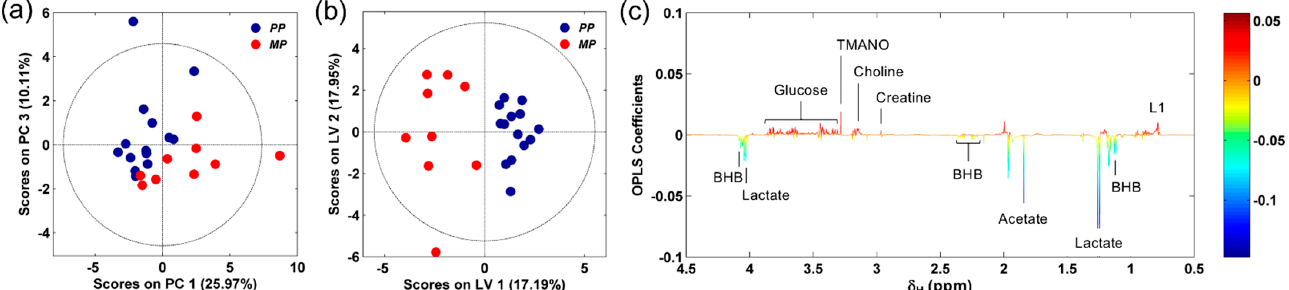
Figure 4. PCA score plot obtained from 1 H NMR spectral data for prepartum (C − 4) serum samples colored according to animal parity ( a ), and score and loading factor plots obtained from the OPLS-DA between primiparous and multiparous dairy cows within this group ( b , c ). The metabolites that differentiate the two groups are annotated in the loading factor plots. The R 2 Y and Q 2 Y coefficients for the model were 0.82 and 0.56, and its ROC curve had an AUC value of 0.93 (see Figures S16 and S17).